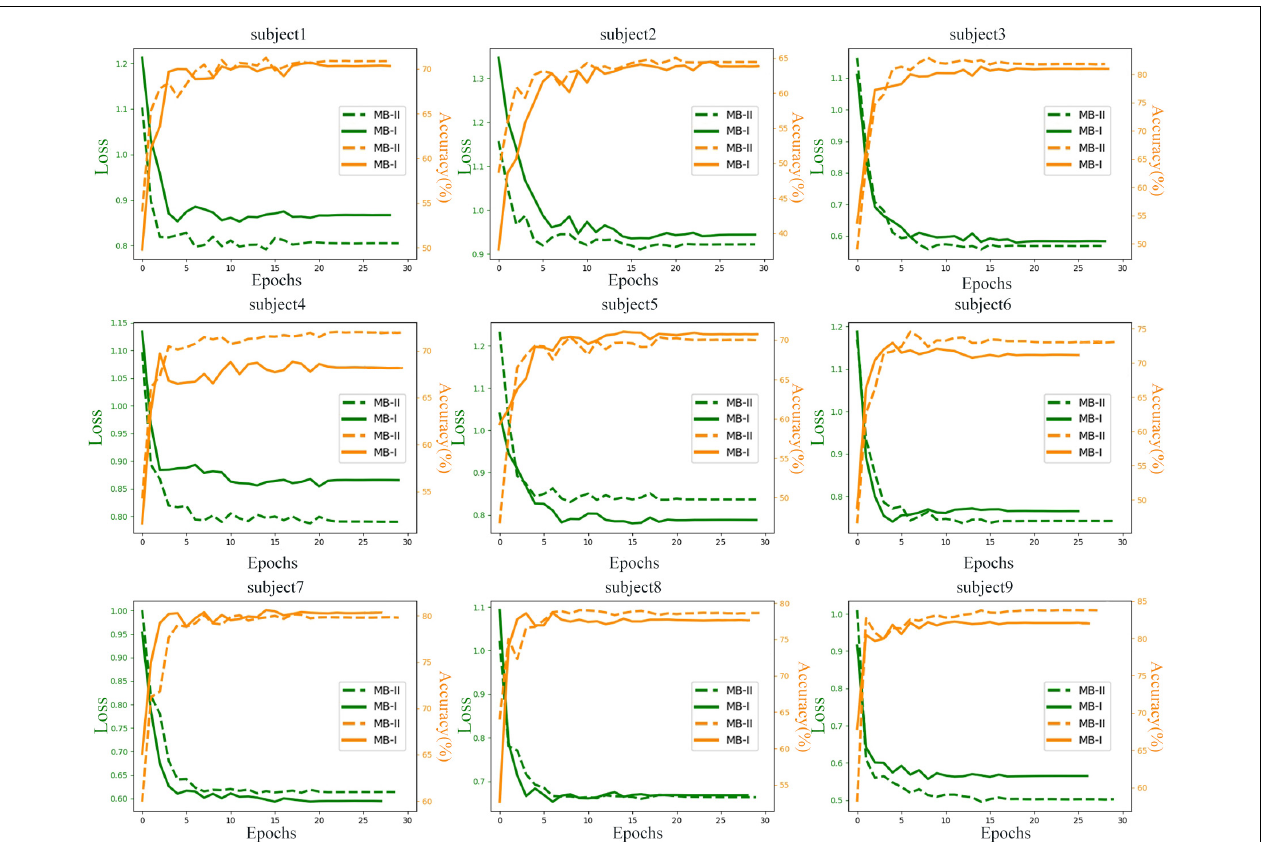
FIGURE 6 | Test loss and accuracy of nine subjects in thirty